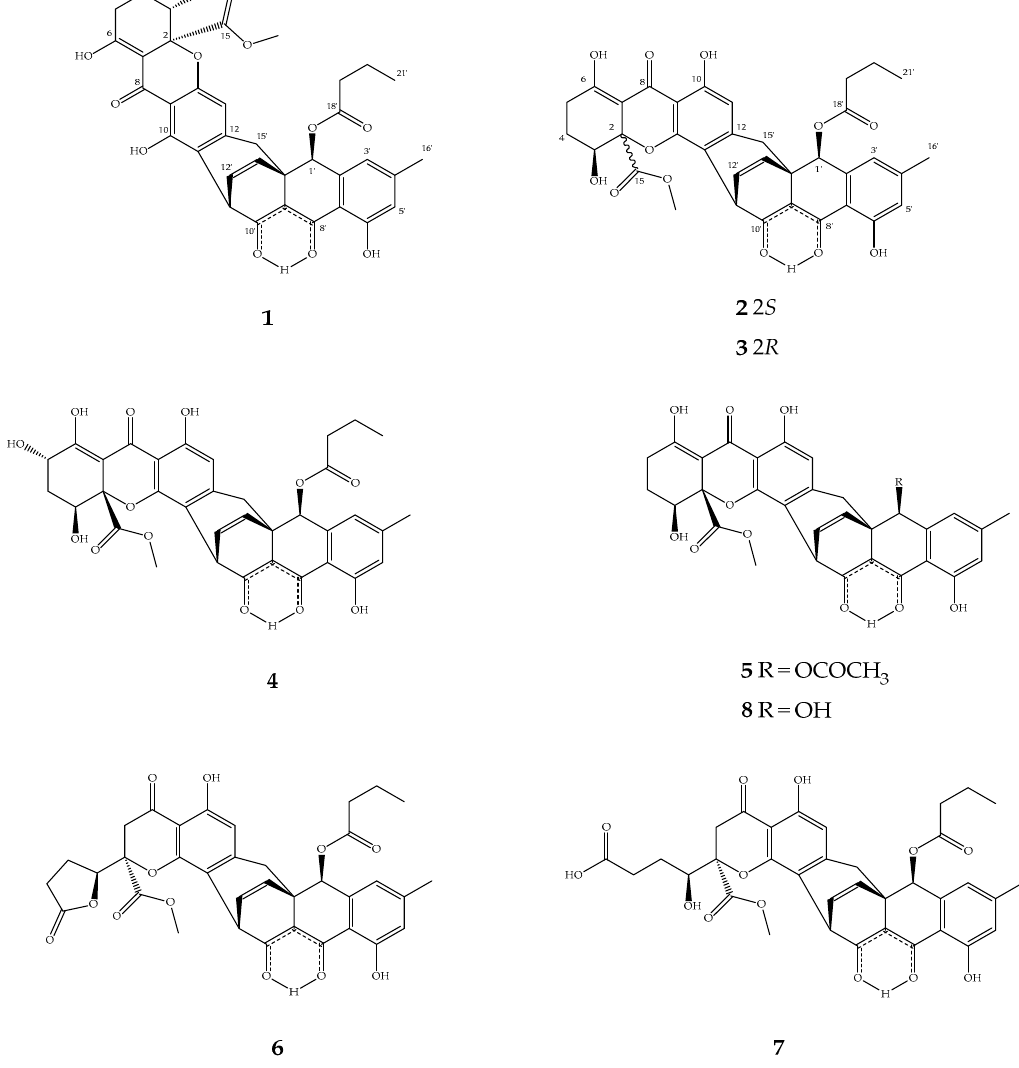
Figure 1. Chemical Structures of Compounds 1 – 8 .